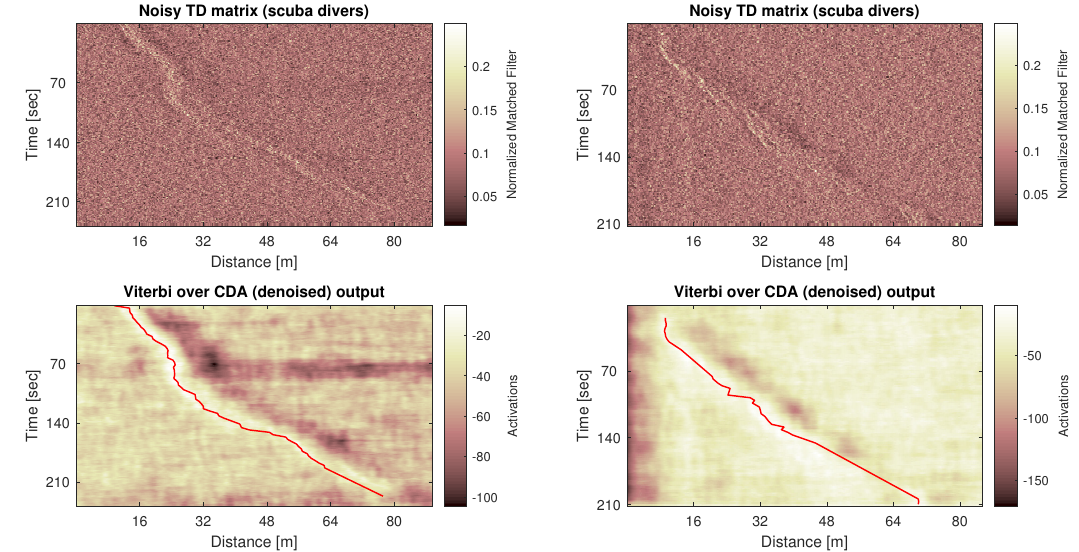
Figure 7. Application of the proposed methodology to TD matrices recorded from the movement of scuba divers.